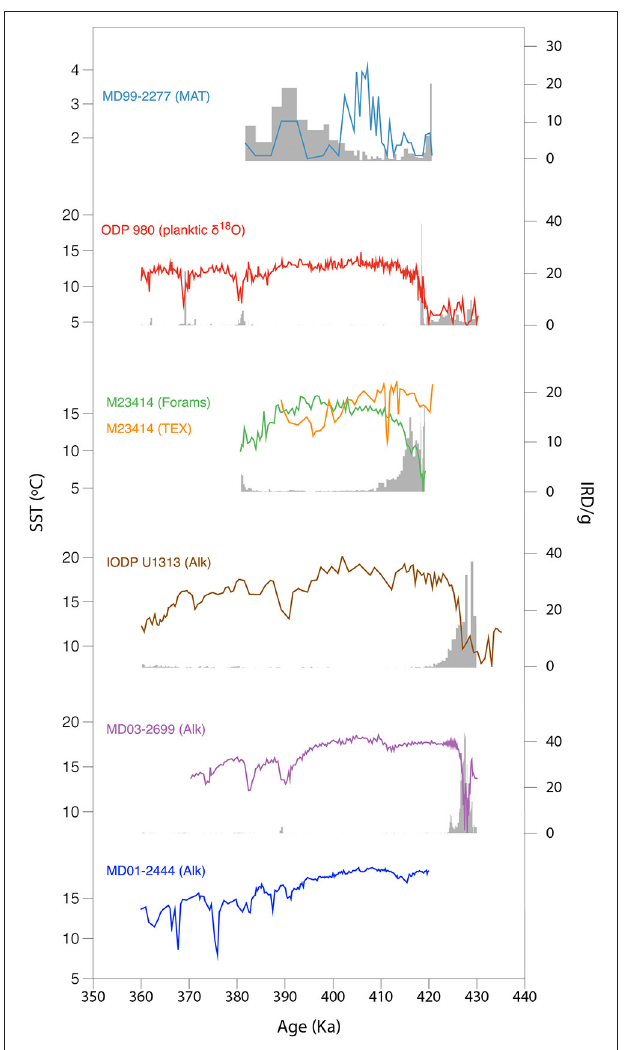
FIGURE 4 | SST and IRD records. (Top to bottom) SST (Kandiano et al., 2016 ) and IRD > 250 µ m/g (retrieved from pangaea.de; Helmke et al., 2003; Kandiano et al., 2012) from site MD99-2277. SST and IRD > 150 µ m/g from Site ODP 980 (retrieved from ncdc.noaa.gov; McManus et al., 1999). SST and IRD > 150 µ m/g from Site GIK23414-8, analog of M23414 (retrieved from pangaea.de; Kandiano and Bauch, 2007). SST (Stein et al., 2009; Rodrigues et al., 2011) and IRD > 315 µ m/g from Sites IODP U1313 and MD03-2699 (retrieved from pangaea.de; Voelker et al., 2010). SST from MD01-2444 (Martrat et al., 2007).